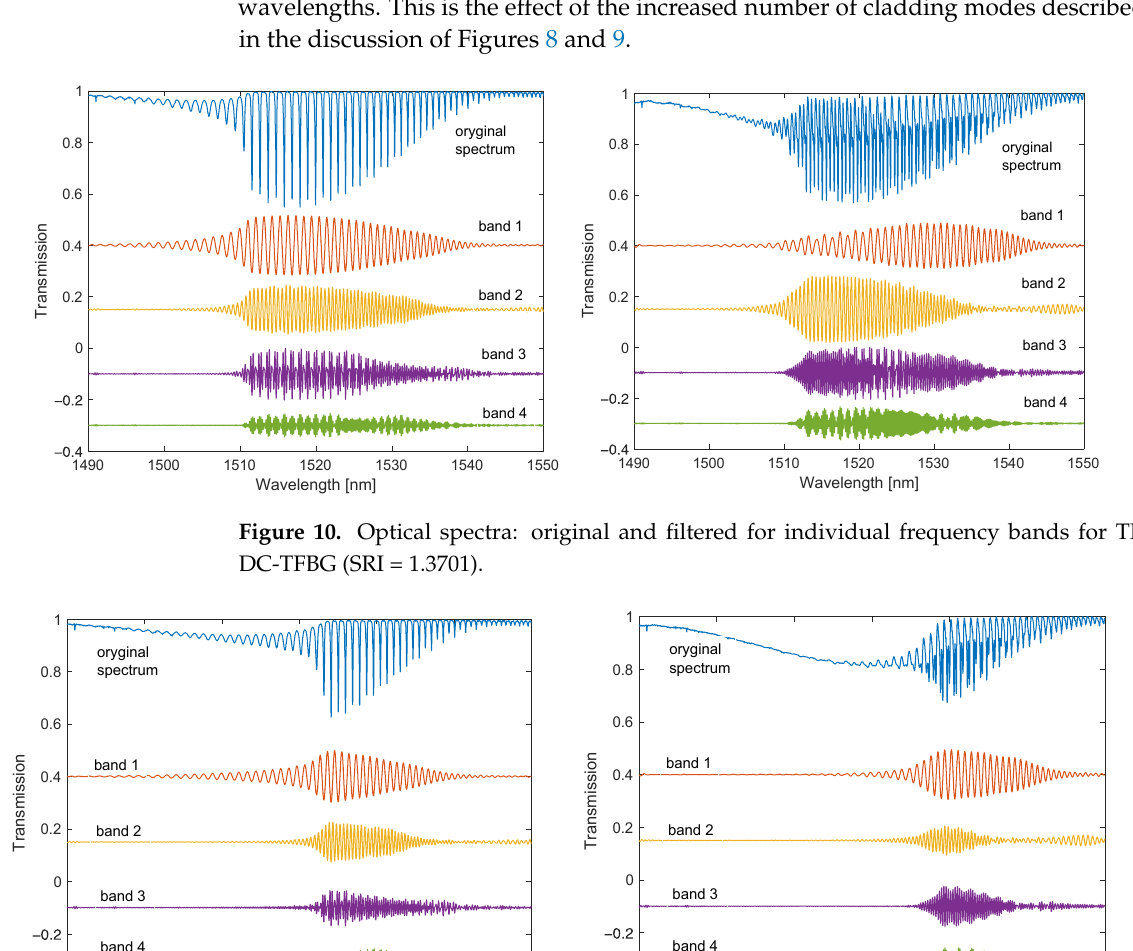
Figure 9. Optical spectra: original and band-filtered for individual frequency ranges for the TFBG and DC-TFBG (SRI = 1.333).